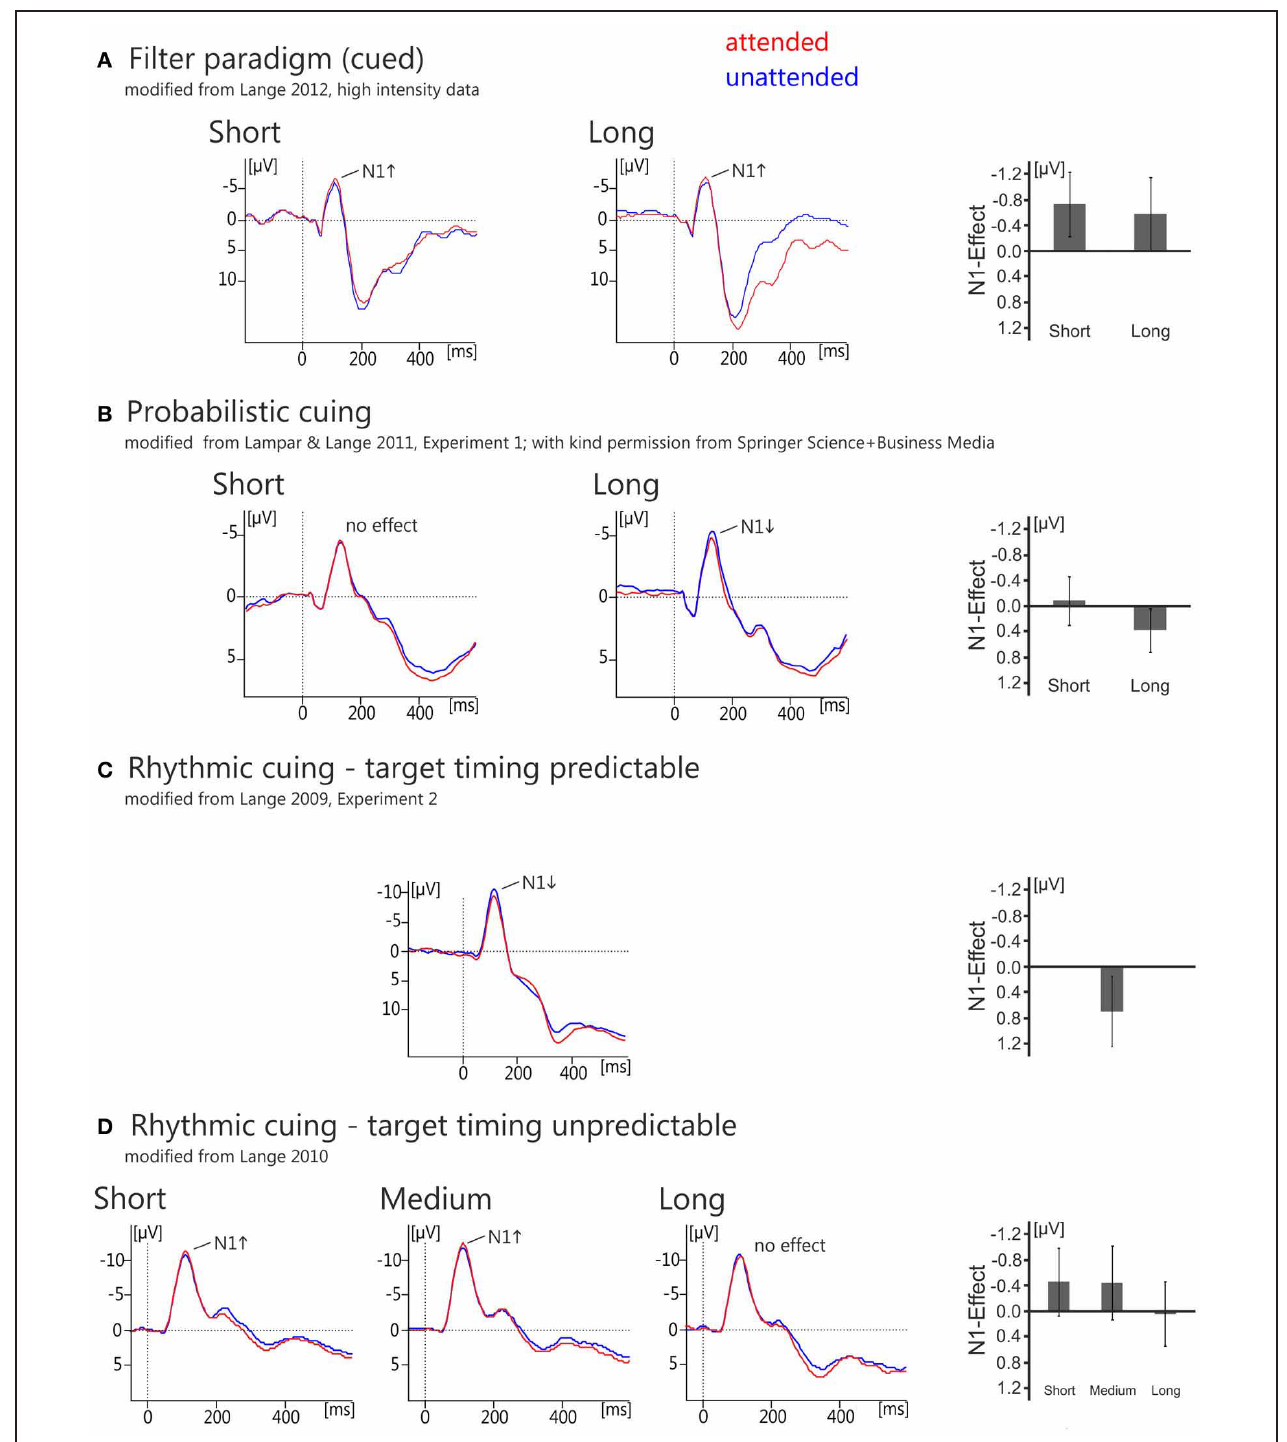
FIGURE 2 | Overview of grand average ERP waveforms (left) and bar graphs of the effects (right) showing the N1-effects of temporal orienting as measured in temporal filter tasks (A), temporal probabilistic cuing (B), and rhythmic cuing with and without predictability of target timing (C,D). For the filter task (A) and probabilistic cuing (B) , ERPs are shown for electrode Cz and C3, respectively, separately for the short and the long interval. Traces are aligned to a post-stimulus baseline from 0 to 50ms.